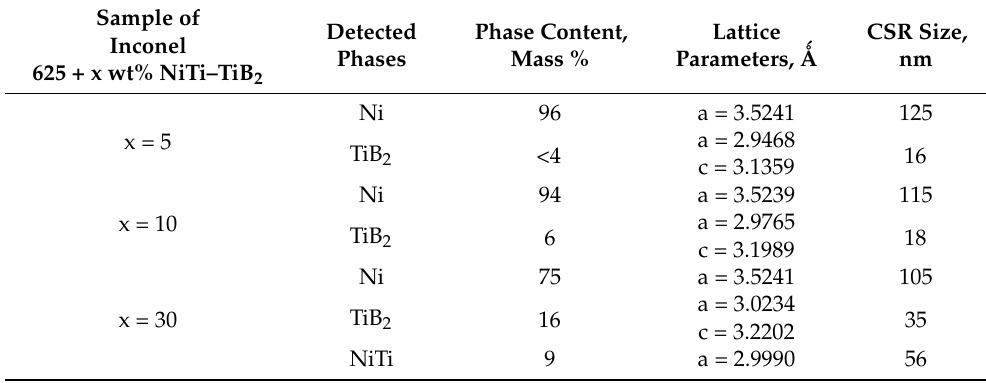
Table 2. X-ray diffraction analysis results for composites obtained by direct laser deposition from a Inconel 625–NiTi–TiB 2 powder